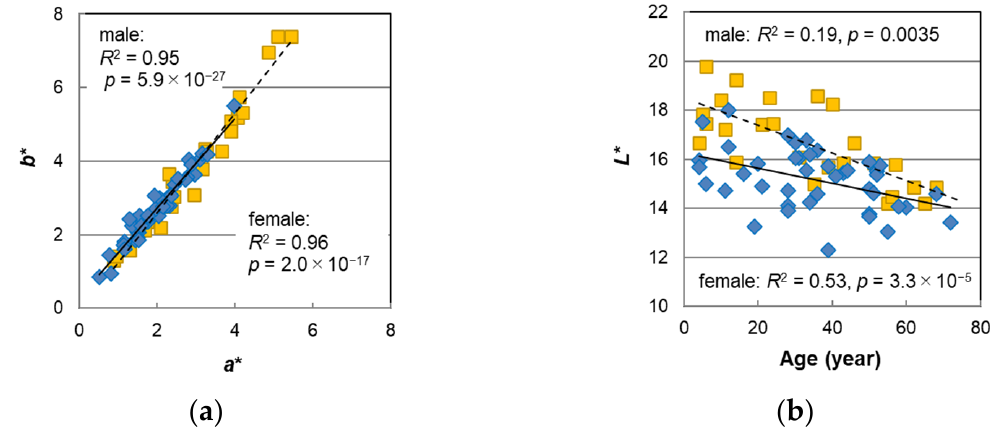
Figure 6. The sex differences of hair color parameters. ( a ) b * vs. a *. ( b ) L * plotted against subject age. Diamond denotes male sex; squares denote female sex. Lines represent the fitted curves. Solid line denotes male sex and dashed line denotes female sex. The coefficients of determination and p -values are shown in each figure.